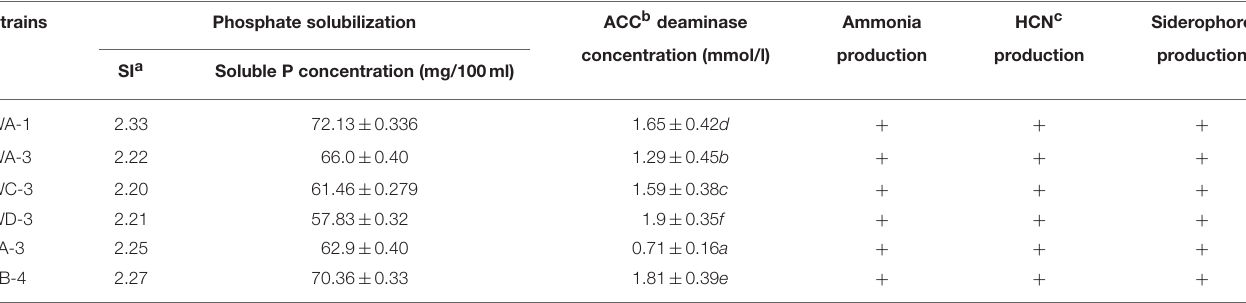
TABLE 3 | Plant growth promoting traits of the selected rhizospheric actinomycetes under in-vitro conditions.